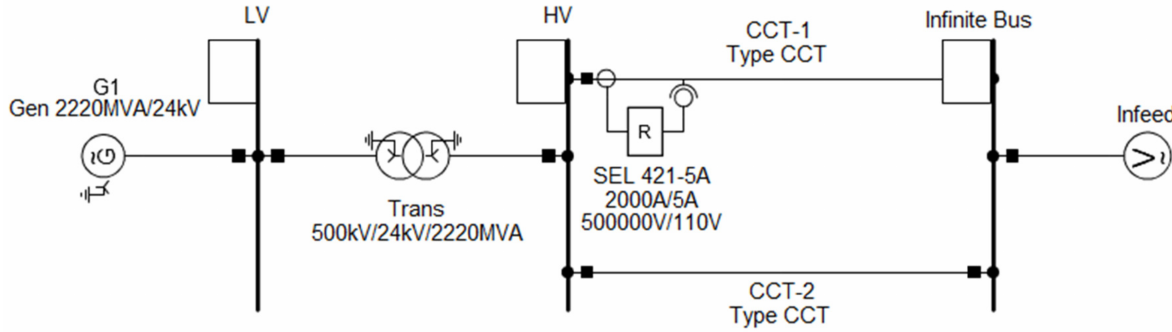
Figure 12. Illustrative Test System: Single Machine-Infinite-Bus (SMIB) considering a 500 kV transmission